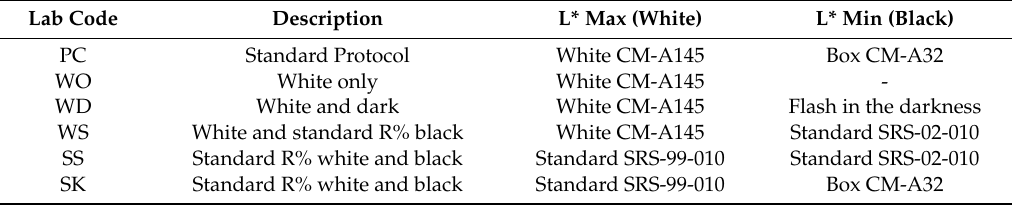
Table 3. Di ff erent procedures of adjustment employed in the color measurements on Spectralon ® color standards and on